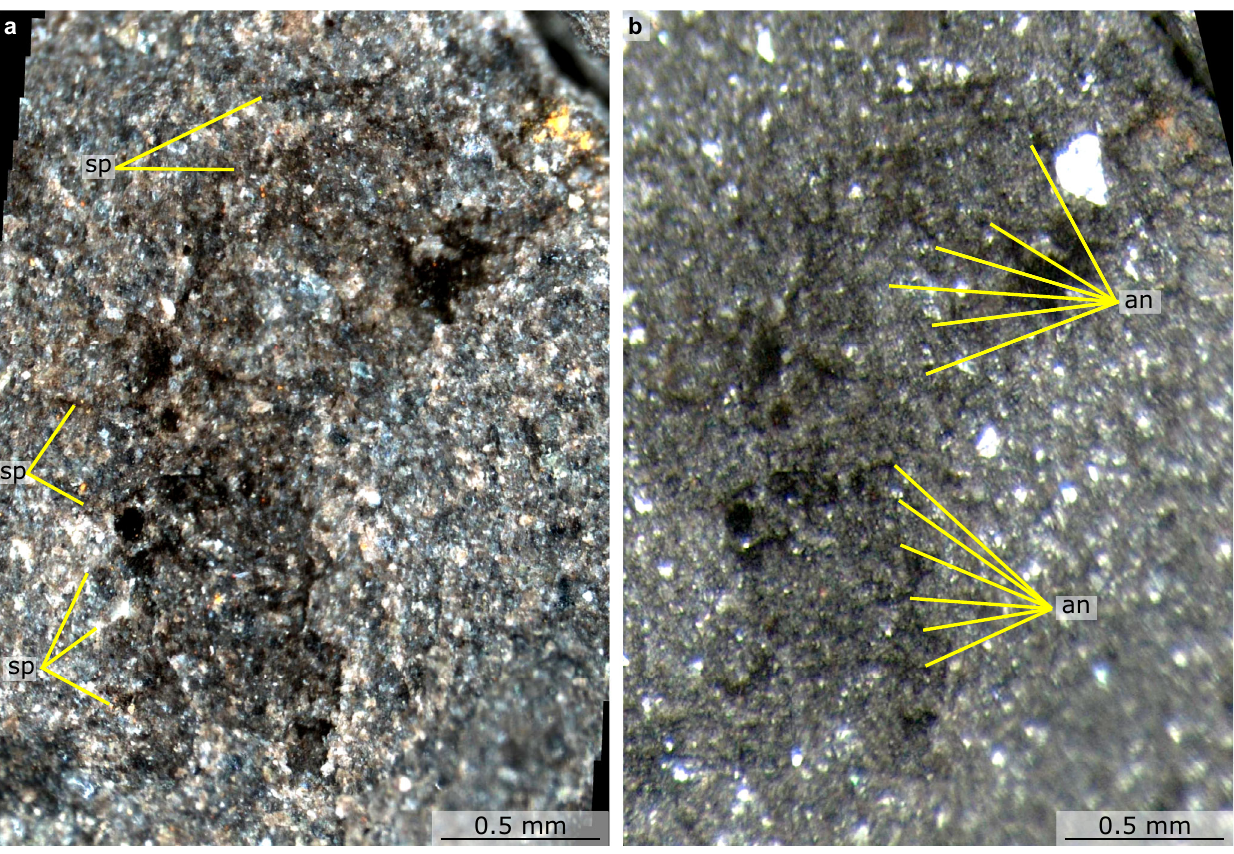
Fig. 3 | Details of proboscis of Mieridduryn bonniae nov. gen. et sp. (NMW.2021.3G.7) under different lighting conditions. a S8 microscope, cross-polarised light, stitched images, with contrast increased. b M125 microscope under high angle light. an annulation, sp